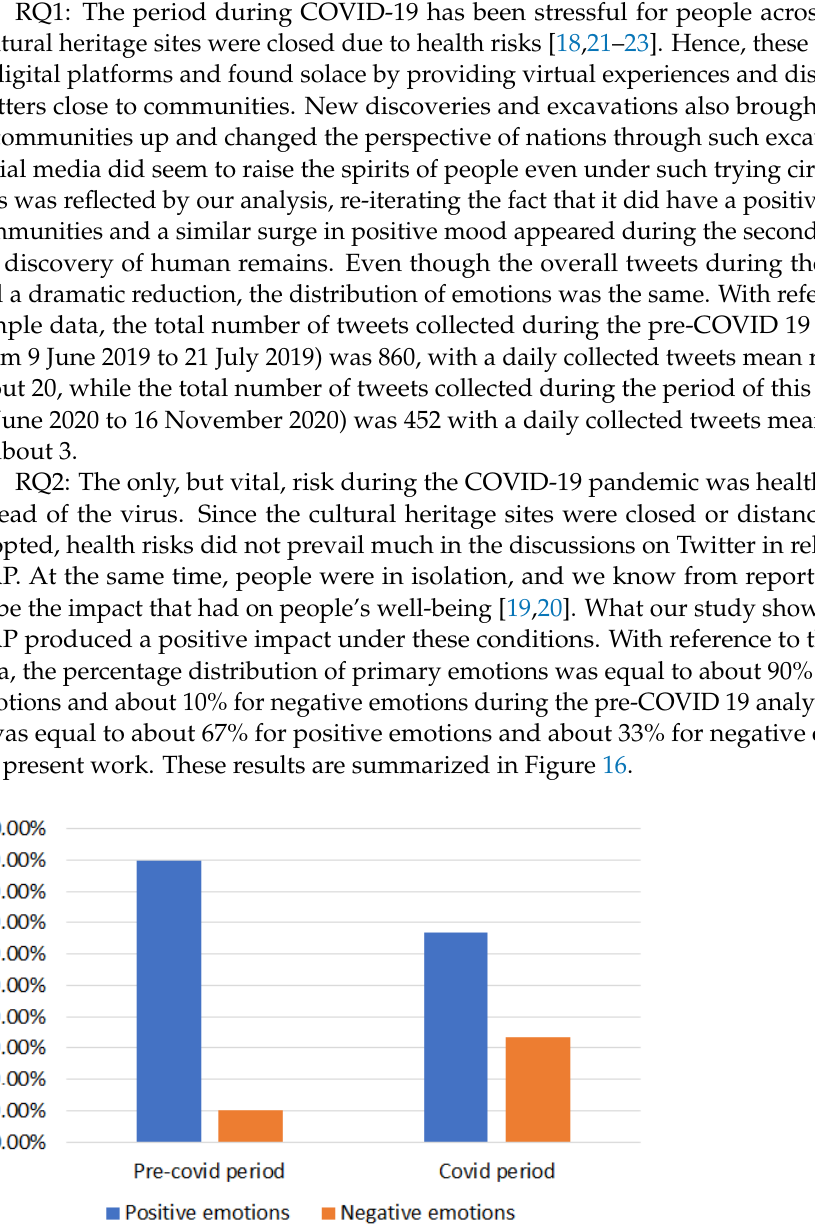
Figure 16. Percentage distribution of primary positive and negative emotions both for English and Italian words before and during COVID-19 pandemic.